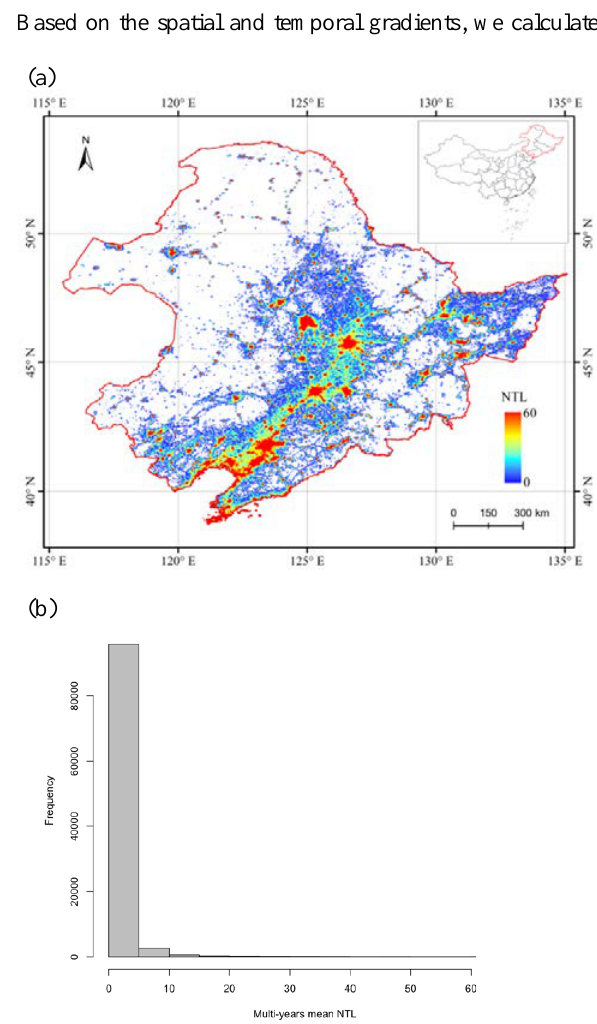
Figure 1. multi-years mean of night-time lights in northeastern